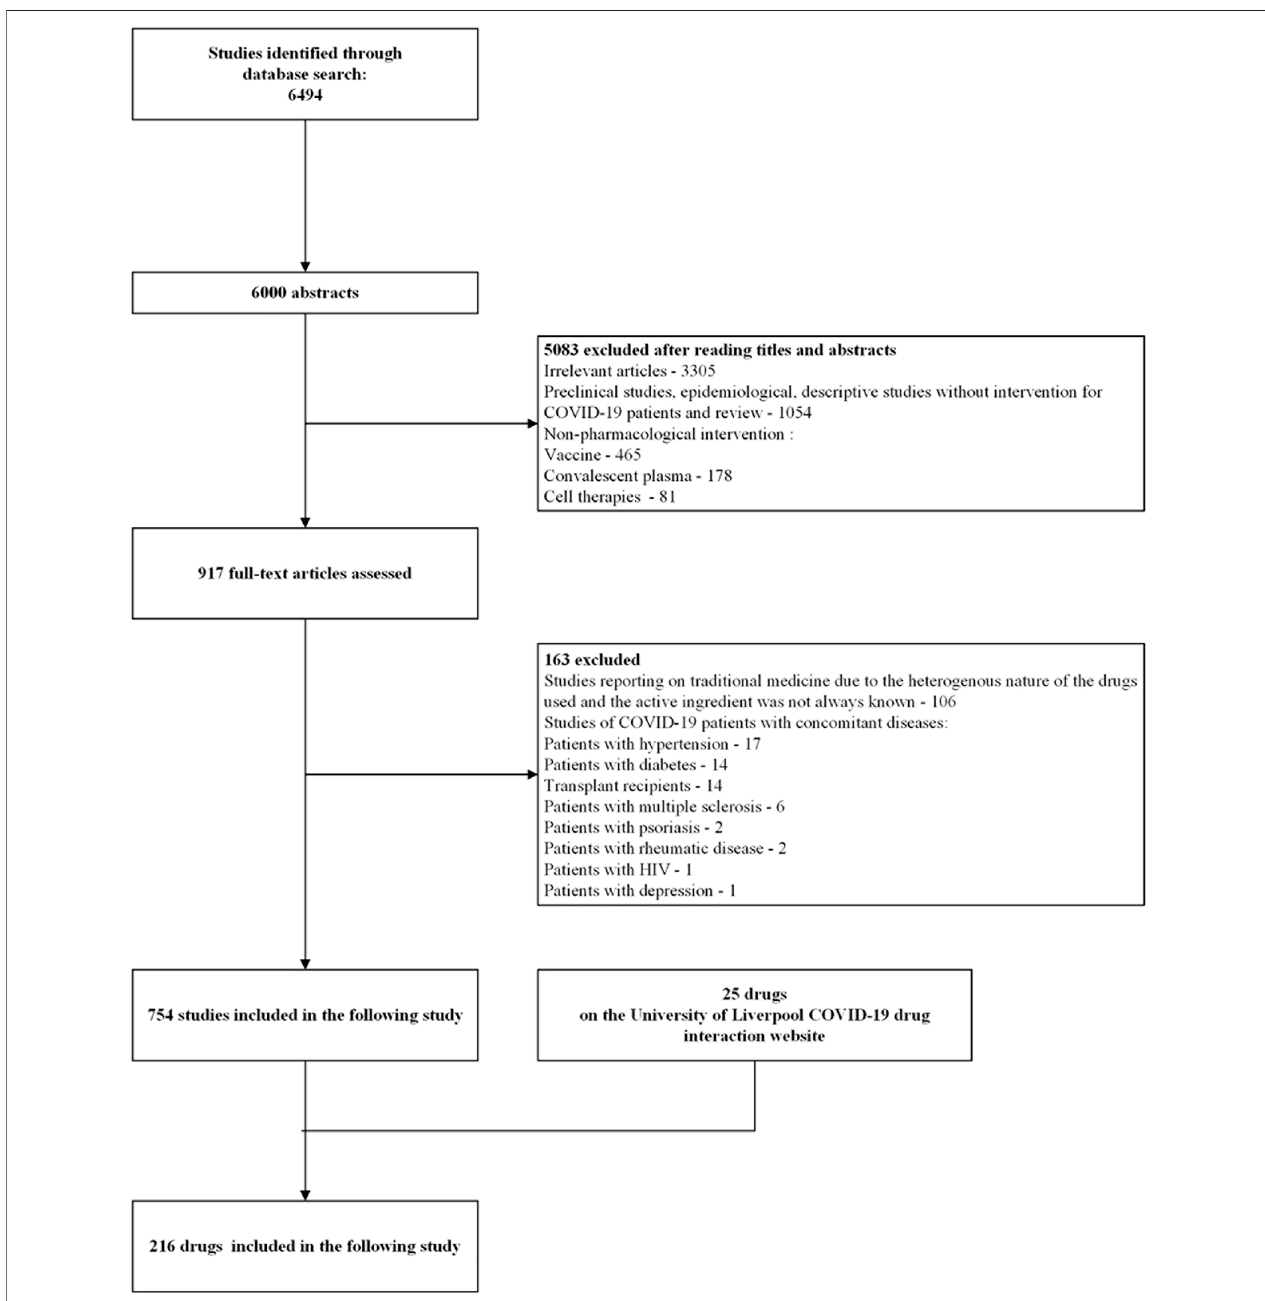
FIGURE 2 | Flowchart of drugs of pharmacologic treatment against SARS-CoV-2 inclusion.